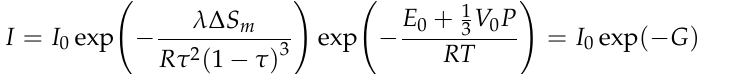
Figure 5. Length-diameter ratio of eutectic Si under different pressures.